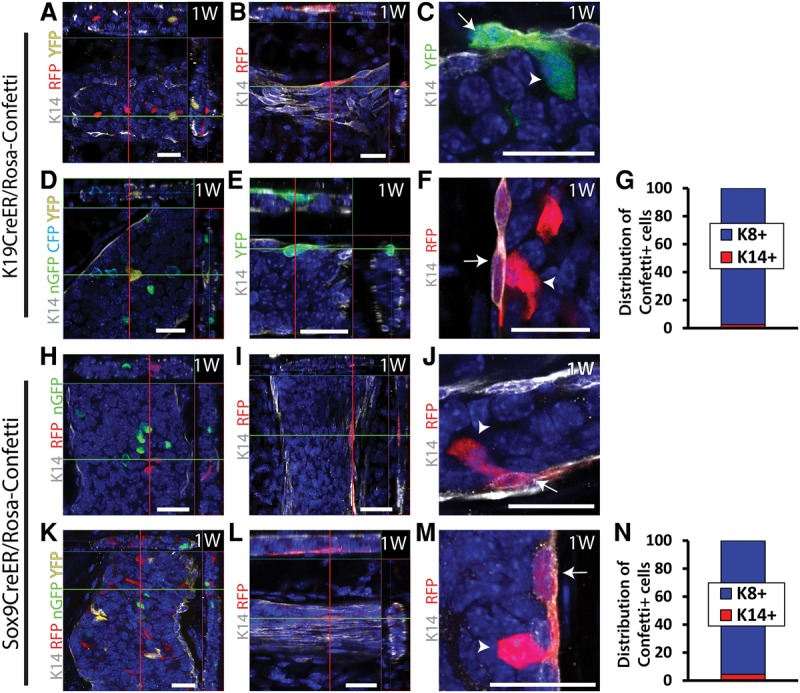
Colabeling of LCs and BCs by K19 and Sox9CreER in the MG. (A–F) Confocal imaging of immunostaining of K14 and Confetti cells 1 wk after TAM administration (15 mg) to K19CreERT/Rosa-Confetti pubertal (A–C) or adult virgin (D–F) mice. (A,D) Isolated LC. (B,E) Isolated BCs. (C,F) Doublets of BCs and LCs. (G) Distribution of basal K14+ and luminal K8+ cells among Confetti+ cells (21,408 cells out of three mice). (H–M) Confocal imaging of immunostaining of K14 and Confetti cells 1 week after TAM administration (5 mg) to Sox9CreERT2/Rosa-Confetti pubertal (H–J) or adult virgin (K–M) mice. (H,K) Isolated LCs. (I,L) Isolated BCs. (J,M) Doublets of BCs and LCs. (N) Distribution of basal K14+ and luminal K8+ cells among Confetti+ cells (4258 cells out of three mice). Arrows depict BCs, and arrowheads depict LCs. (A,B,D,E,H,I,K,L) Orthogonal projections of 3D stacks. (C,F,J,M) Single-plane images from a 3D stack. Bars, 20 µm. Histograms represent the mean. See Supplemental Table S2 for further information on the statistics.